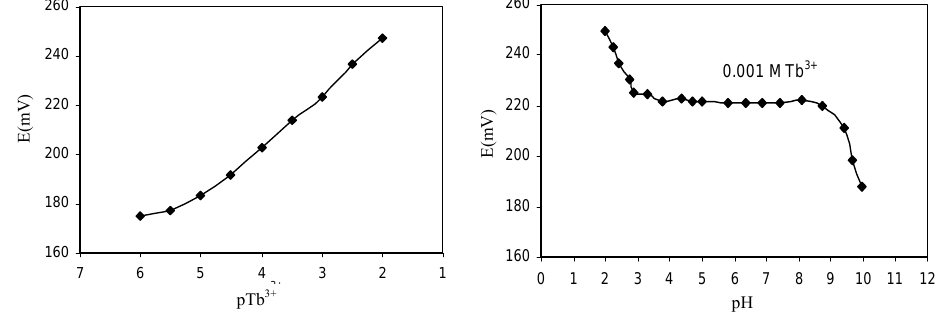
Figure 3. The pH effect of the test solution on